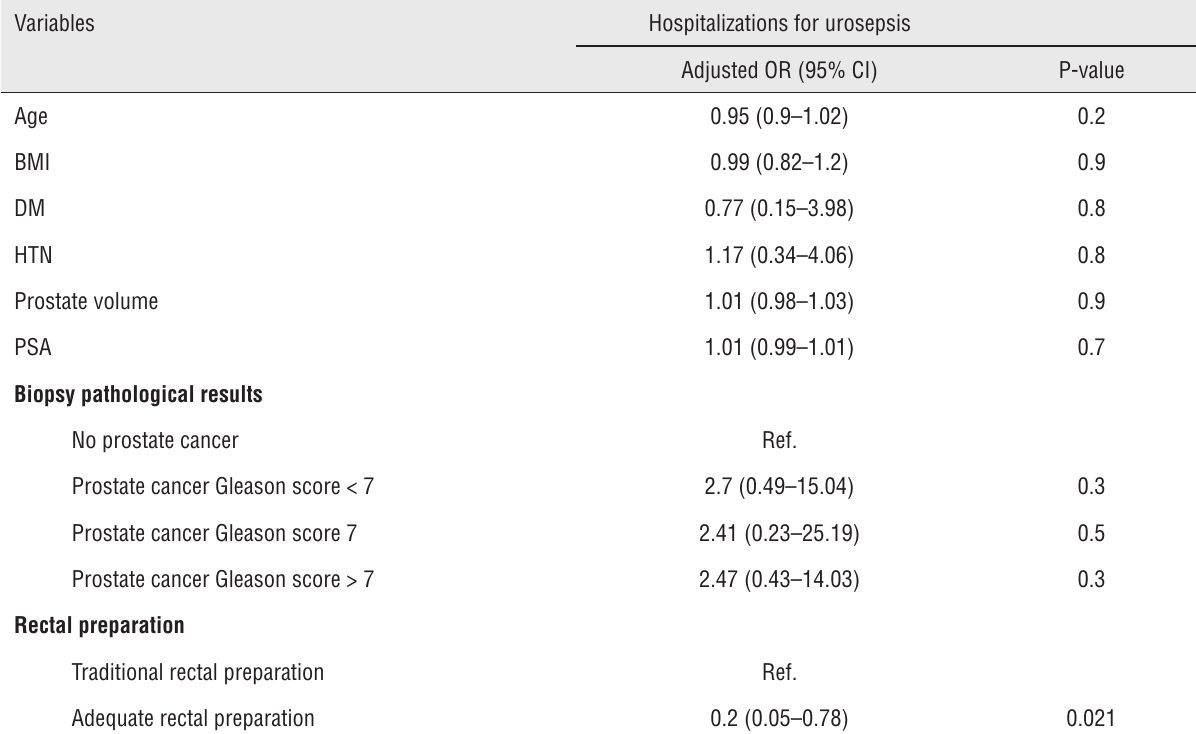
Table 2 - Logistic regression of potential factors on hospital admissions for urosepsis.